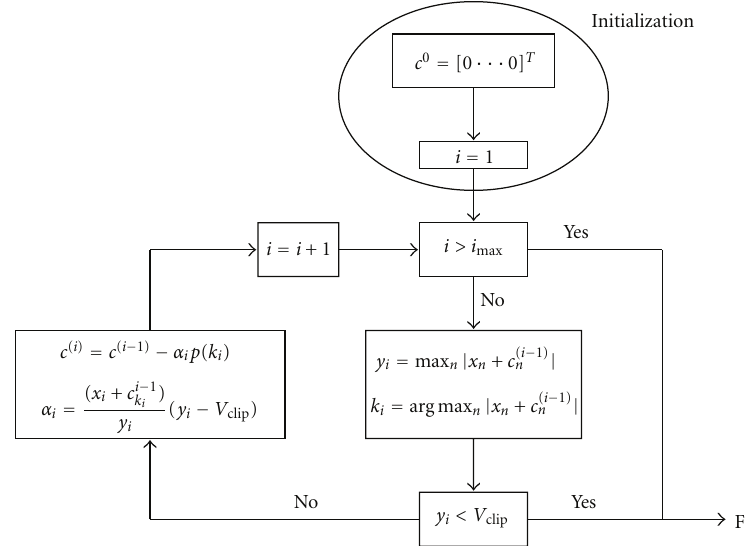
Figure 3: Principle of gradient iterative algorithm proposed in DVB-T2.